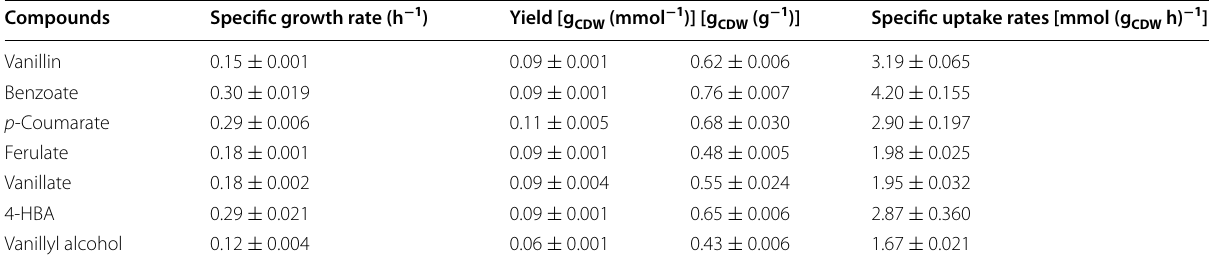
Table 4 Specific growth rates, yields and uptake rates of Pseudomonas sp. isolate 9.1 on lignin model